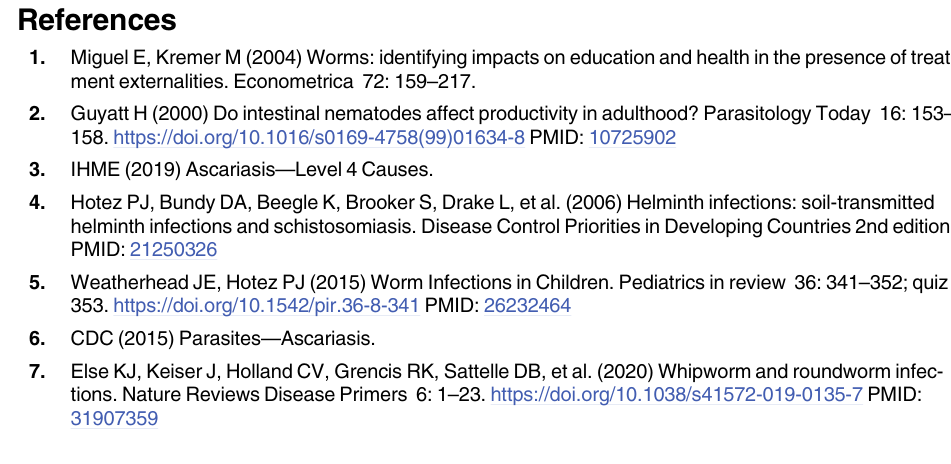
S4 Fig. Flow cytometry gating strategy for alveolar and interstitial macrophages.